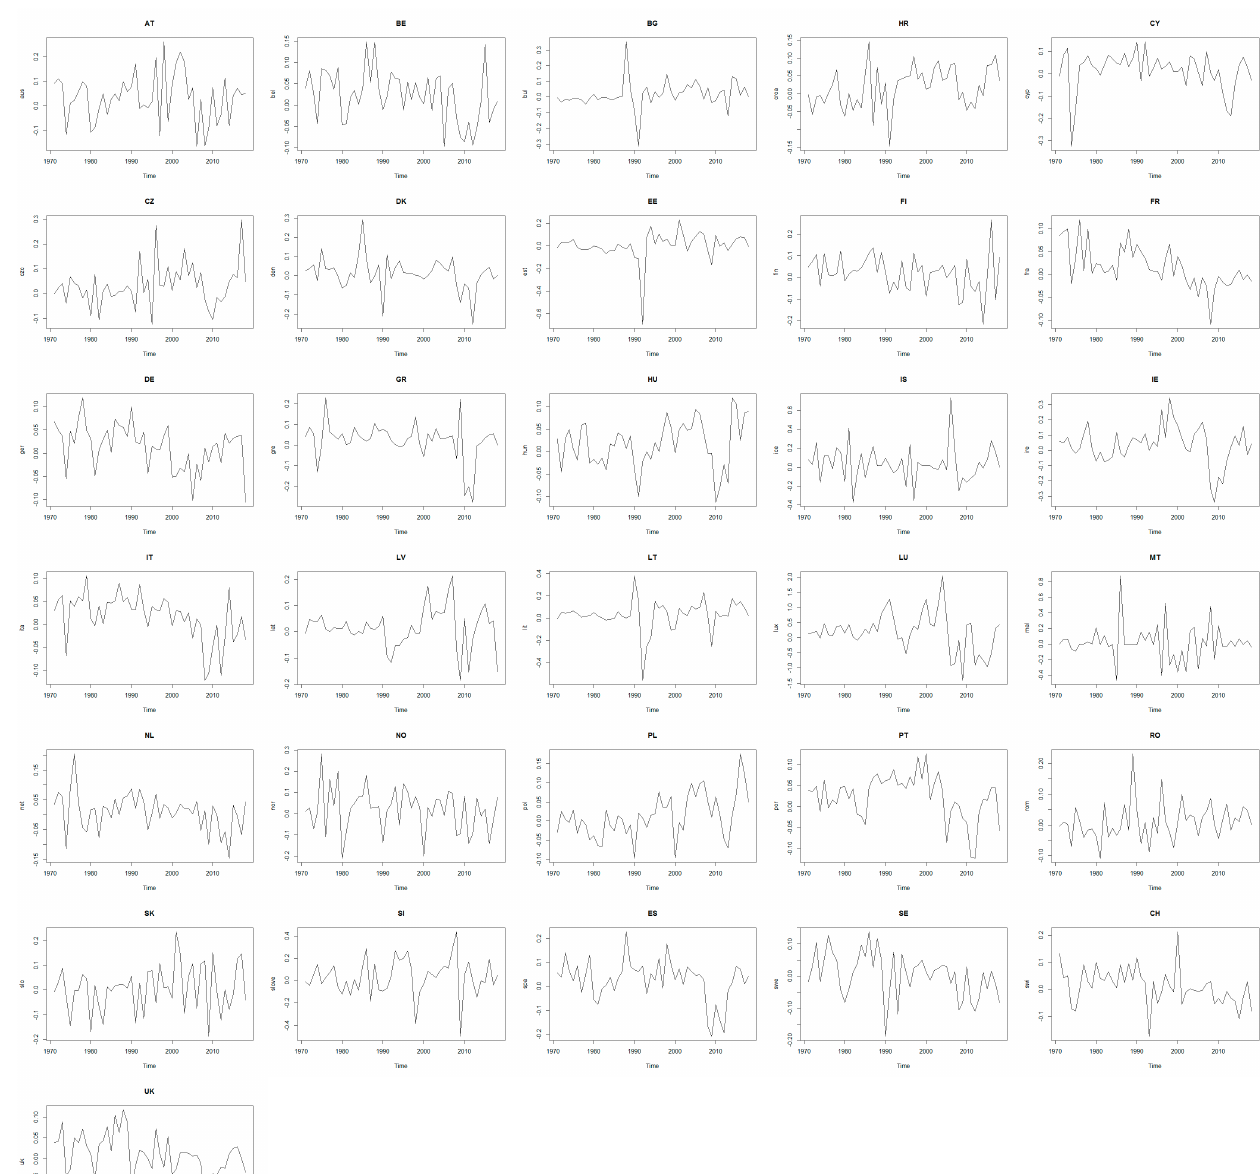
Figure 2. Time-series plot of the annual CO 2 emission changes from 1970 to 2018.